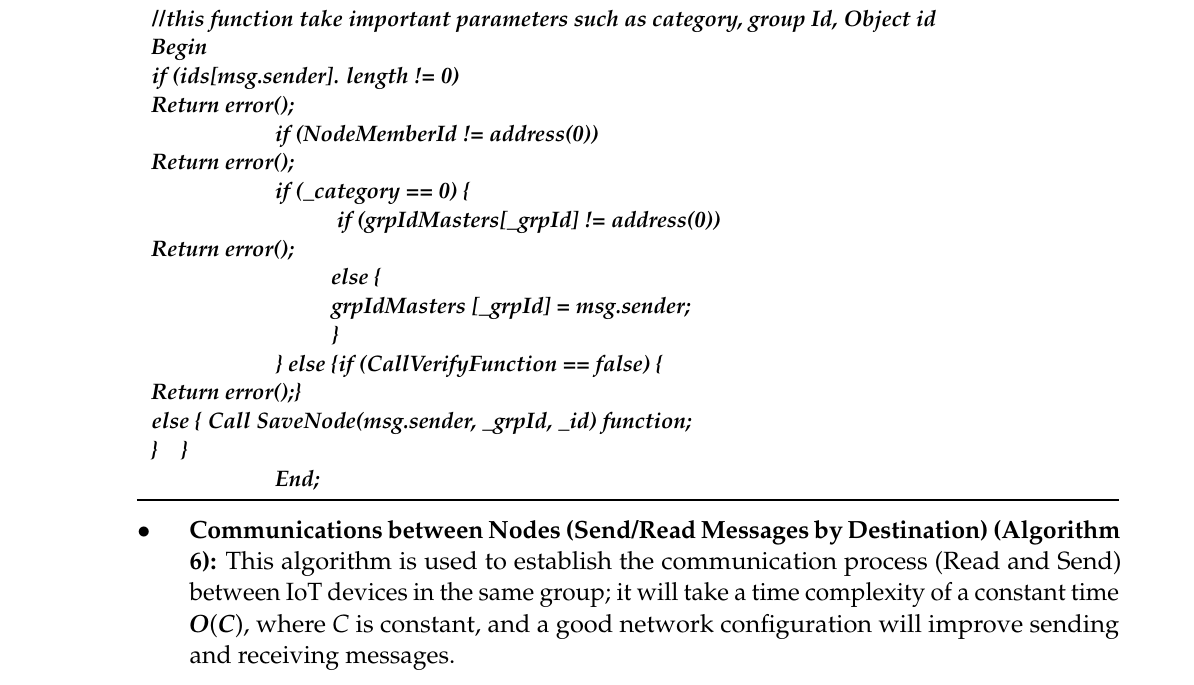
Algorithm 5: Add Node to